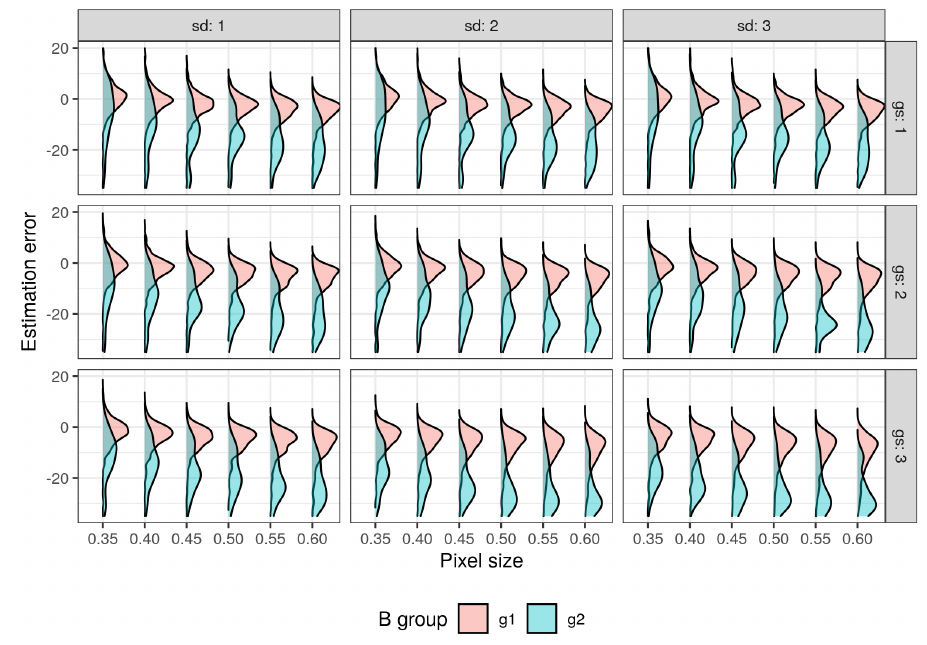
Figure 10. Distribution of estimation error of number of trees on sample plots in B category groups (sample plot size g1: r ≤ 12.62 m and g2: r > 12.62 m) dependent on Watershed method parameterization—Canopy Height Model (CHM) spatial resolution (pixel size in meters), Gaussian smoothing strength (Gaussian filter window size (gs) and standard deviation (sd) in